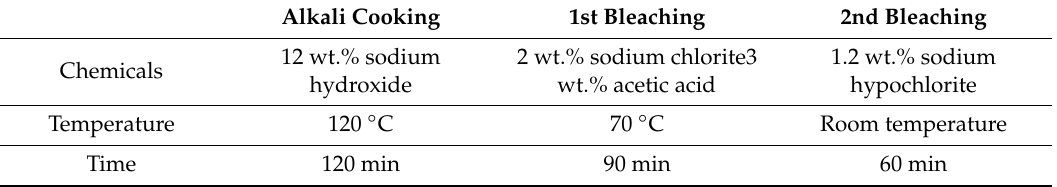
Table 2. Alkali cooking and a two-step bleaching process for the isolation of cellulose.